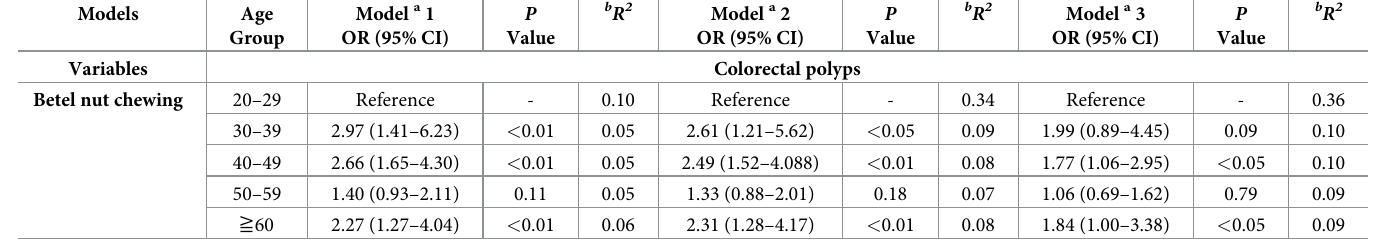
Table 5. Different age groups in association between betel nut chewing and the presence of colon polyps.